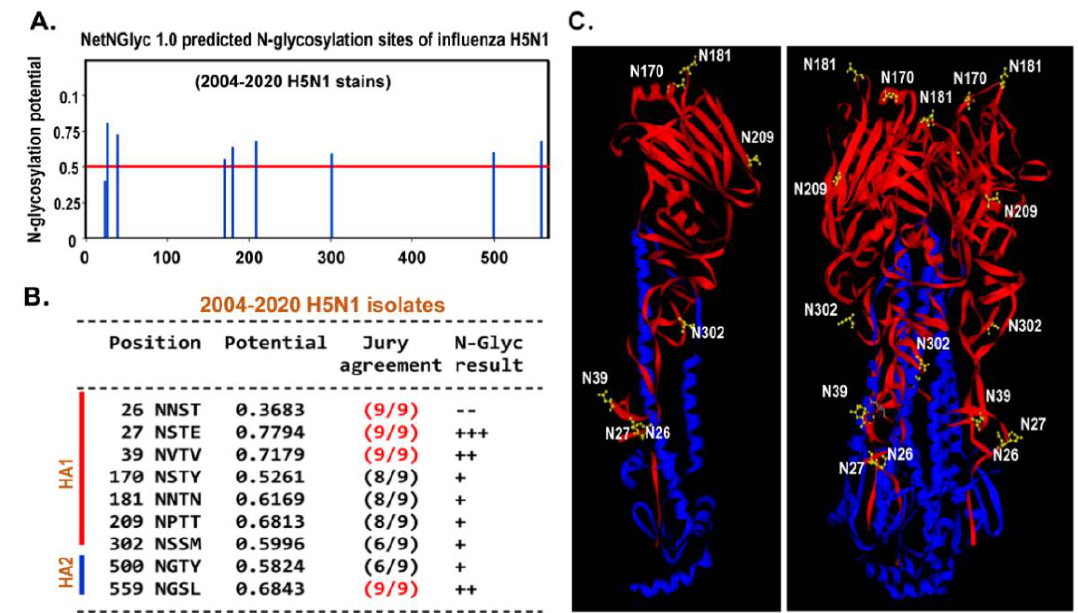
Figure 2. N-linked glycosylation analysis of HA protein of influenza H5N1 viruses. The full-length of HA nucleotide sequences form avian influenza H5N1 viruses isolated from infected persons during 2004–2020. The sequences were subjected to prediction of N-linked glycosylation on hemagglutinin of H5N1 influenza strain via by NetNGlyc 1.0 Server. ( A ) A total of nine N-linked glycosylation sites were detected. The red and blue lines indicate the potential threshold of N-linked glycosylation and predicted N-glycosylation sites on HA(H5), respectively. ( B ) There were seven N-glycosylation sites (26, 27, 39, 170, 181, 209, 302) located in HA1 domain, where two (500 and 509) were located in HA2 transmembrane domain. The red words indicate the highest percentage and scores of predicted N-linked glycosylation. ( C ) Each N-glycosylation site on the hemagglutinin structure was labeled; numbers indicate relative amino acid site. The left and right indicate monomeric and trimeric structure of the hemagglutinin of H5N1 influenza viruses. The red and blue structures indicate HA1 and HA2 domain, respectively.